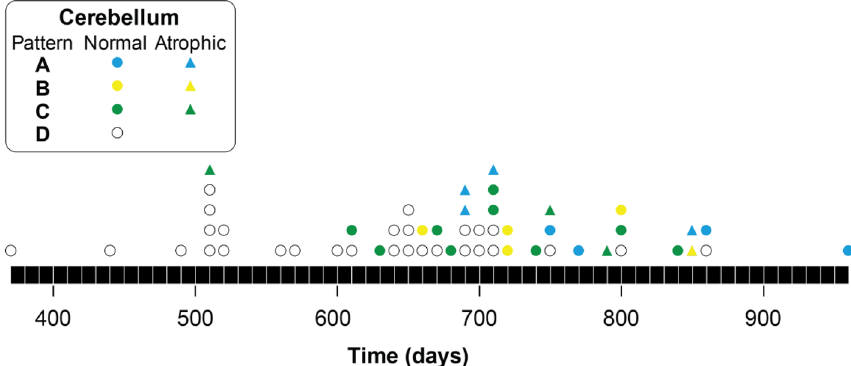
Figure 2. The occurrence of spontaneous neuropathology in ageing Tg20 mice challenged with D-PBS or buffer: The x-axis represents the latency in days from inoculation to death with each symbol representing an individual animal (see Table 1). Triangles represent mice with cerebellar atrophy and circles indicate no atrophy. Blue symbols represent pattern ( A ), yellow symbols pattern ( B ), green symbols pattern ( C ) and ( D ) with open circles representing unaffected animals with no signs of abnormal pathology (see Fig.